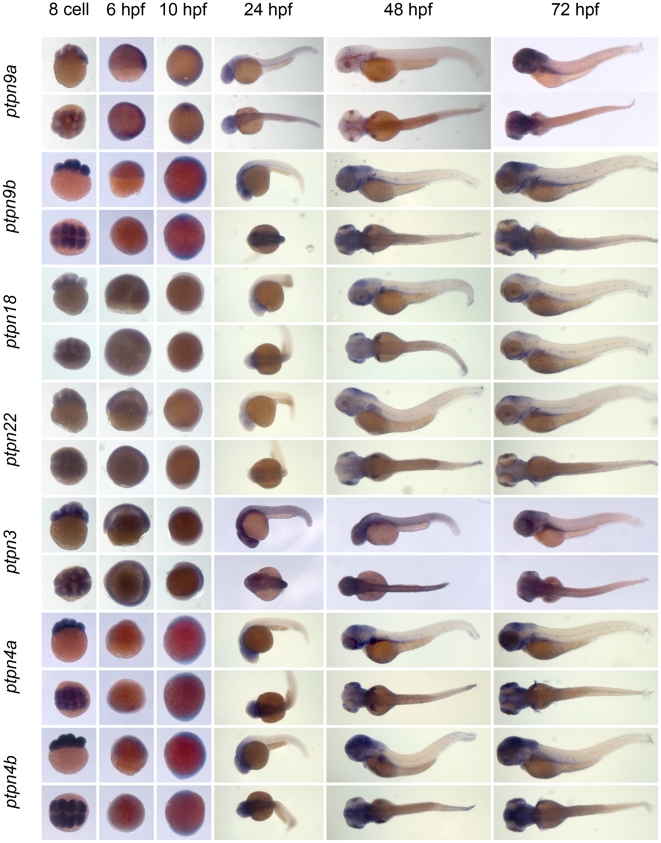
See legend to Fig. 3.